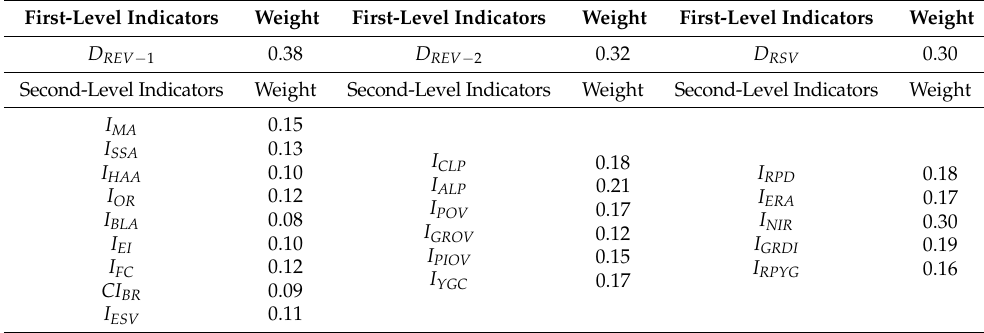
Table 3. Weights of the Indicators at All Levels of the Regional Rural Vulnerability Evaluation. First-Level Indicators Weight First-Level Indicators Weight First-Level Indicators